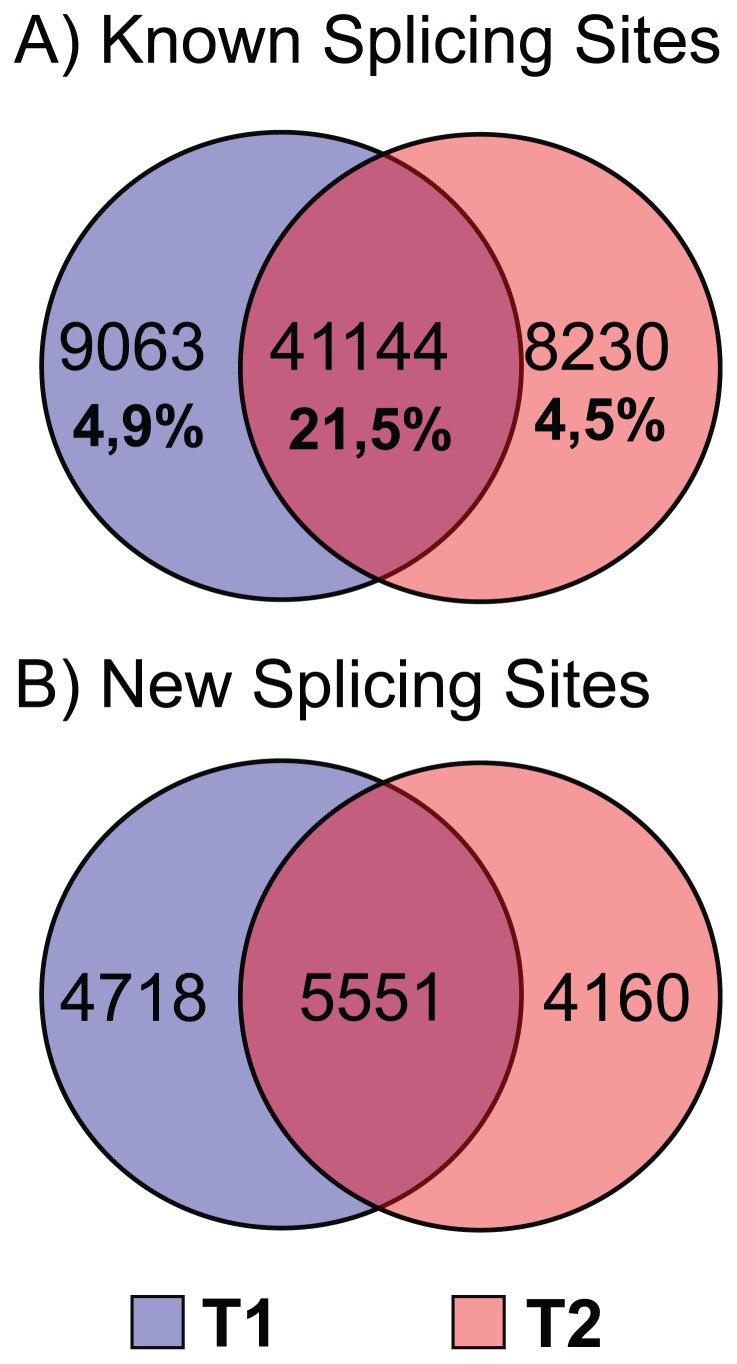
Venn diagram showing the number of splice sites identified in the T1 and T2 samples.A) Splicing sites confirmed by previously reported annotation of horse genes. B) Novel splicing sites.